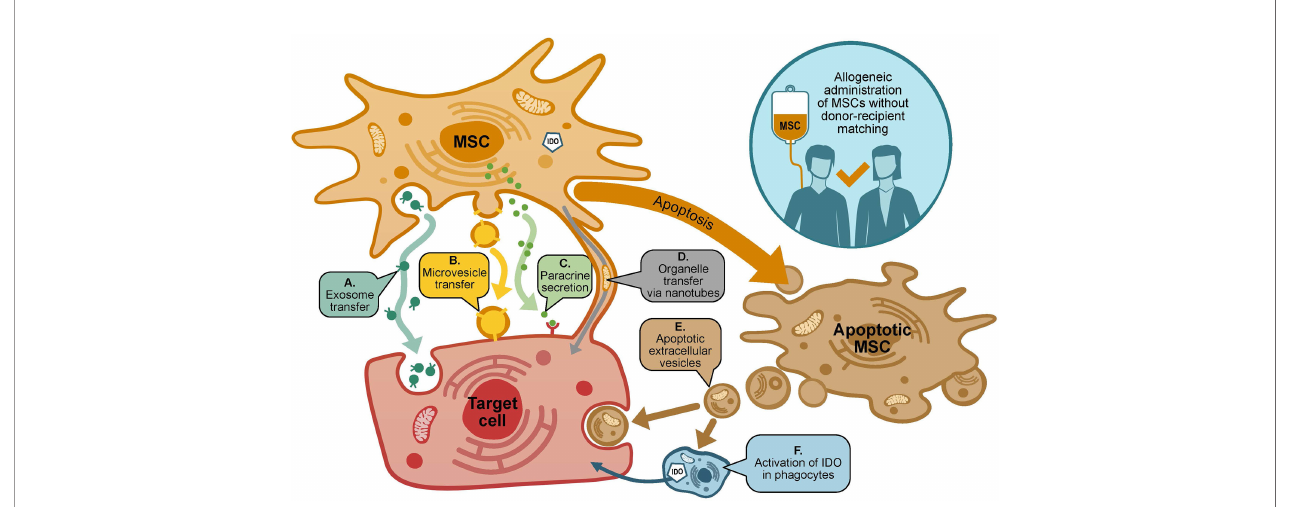
FIGURE 1 | Mechanisms of action of MSCs in GvHD. MSCs may exert many effects on target cells via diverse potentially-overlapping mechanisms. Target cells include (i) donor and host immune cells, including T cells, B cells, NK cells, monocytes and dendritic cells; and (ii) host cells susceptible to damage by GvHD, e.g. cells of the skin, gastrointestinal tract and liver. Potential mechanisms through which MSCs may act include (A, B) : transfer of exosomes or microvesicles containing RNA and other molecules; (C) paracrine activity including secretion of proteins (including IDO), peptides and hormones; (D) transfer of organelles via tunneling nanotubes; (E, F) MSC apoptosis results in the release of apoptotic extracellular vesicles that act on target cells, as well as induction of IDO production in recipient